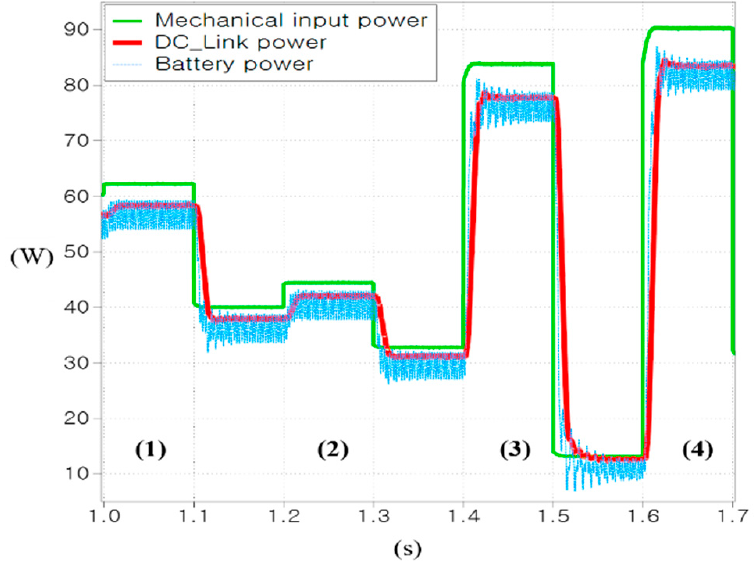
Figure 6. Simulation result using the P&O MPPT method with the proposed step size.